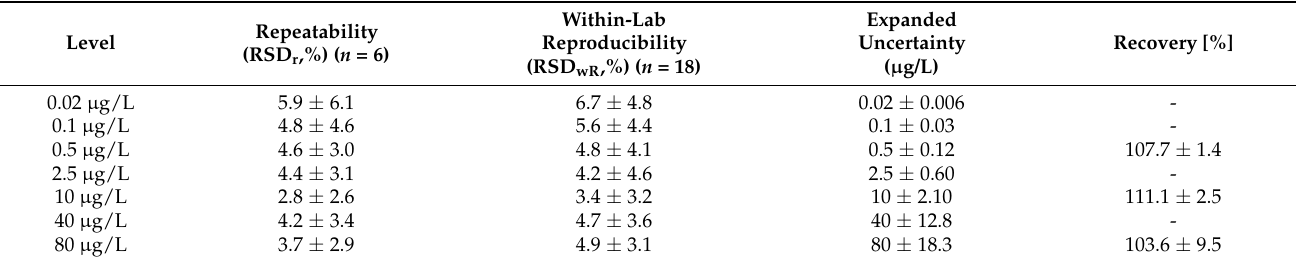
Table 2. Parameters obtained for the calibration curves during validation of normal (non-lipemic) plasma. Level